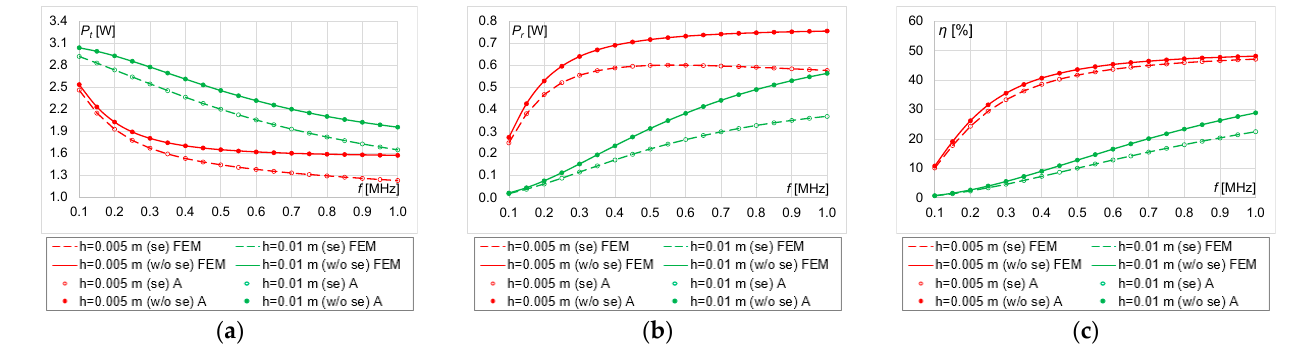
Figure 17. Results for n = 10 for the cases with and without skin effect: ( a ) P t , ( b ) P r , ( c ) η .